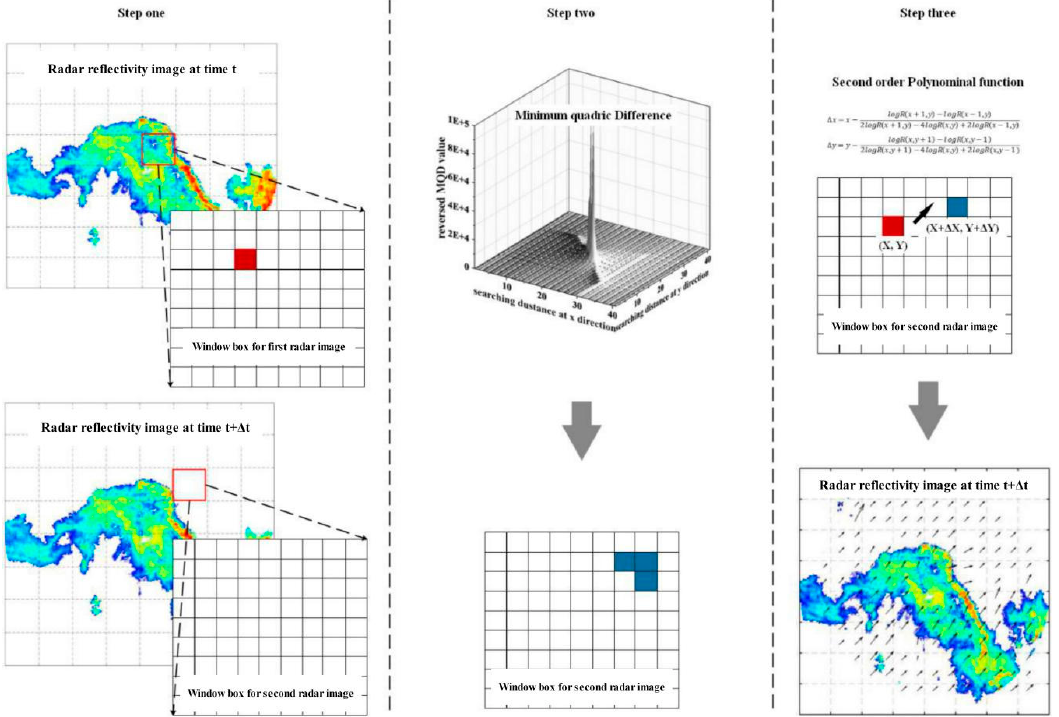
Figure 2. Illustration of particle image velocimetry (PIV) application in rain cell motion estimation. Step one: window boxes with the area of r × r are defined (rectangular with red color); step two: for any grid point in the window box at a previous timepoint (red block), the minimum quadric difference (MQD) algorithm is applied to deduce the minimum reflectivity differences, and grid points with minimum value in the next window box are identified (blue blocks); step three: the solitary locations of reversed MQD value, Δ x and Δ y , are corrected by applying Equation (2). The locations of the optimal grid point at the next timepoint are calculated using the second-order polynomial function, and the global motion vectors are extracted and smoothed by the median filter method.